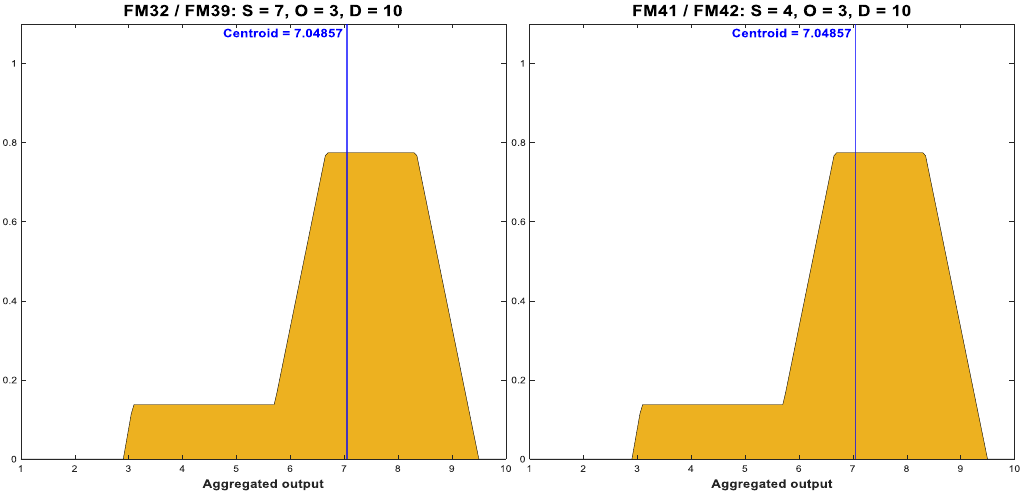
Figure 11. Fired fuzzy rules and aggregated output for failure modes FM41 and FM42.